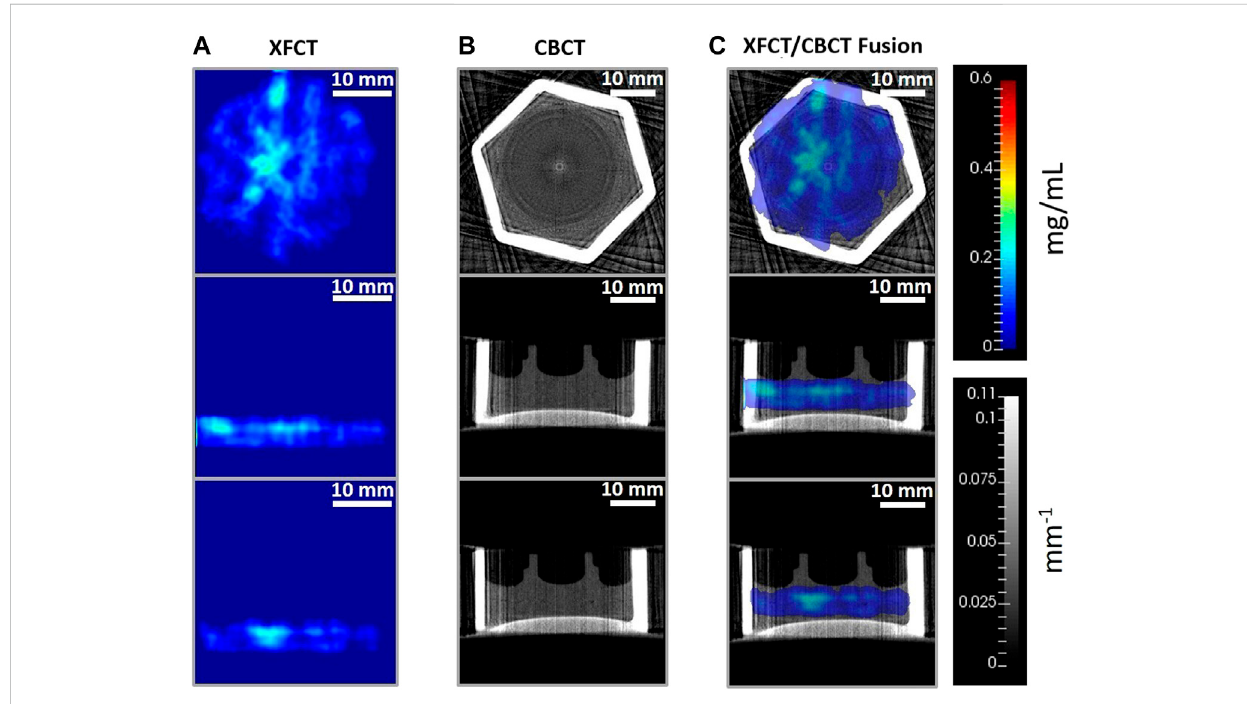
FIGURE 13 Reconstructed axial (top row), sagittal (middle row), and coronal (bottom row) tissue slices from (A) XFCT using anisotropic TV-EM algorithm, (B) CBCT reconstruction from FDK algorithm, and (C) XFCT-CBCT registered images of the multilayer cell-culture sandwich administered with 0.2 mg/mL MoNP solution, imaged at 48h incubation period. The rainbow color bar shows the MoNP concentration (mg/mL). The grayscale color bar shows the attenuation coef fi cients (mm − 1 ). Scale bar: 10 mm.